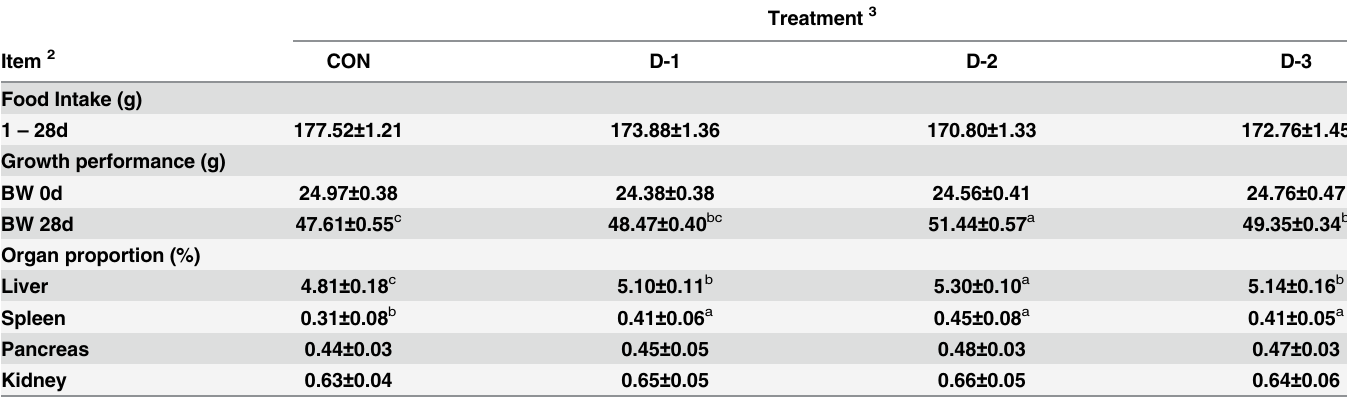
Table 2. Effects of DMG-Na on mice growth performance and organ proportion 1